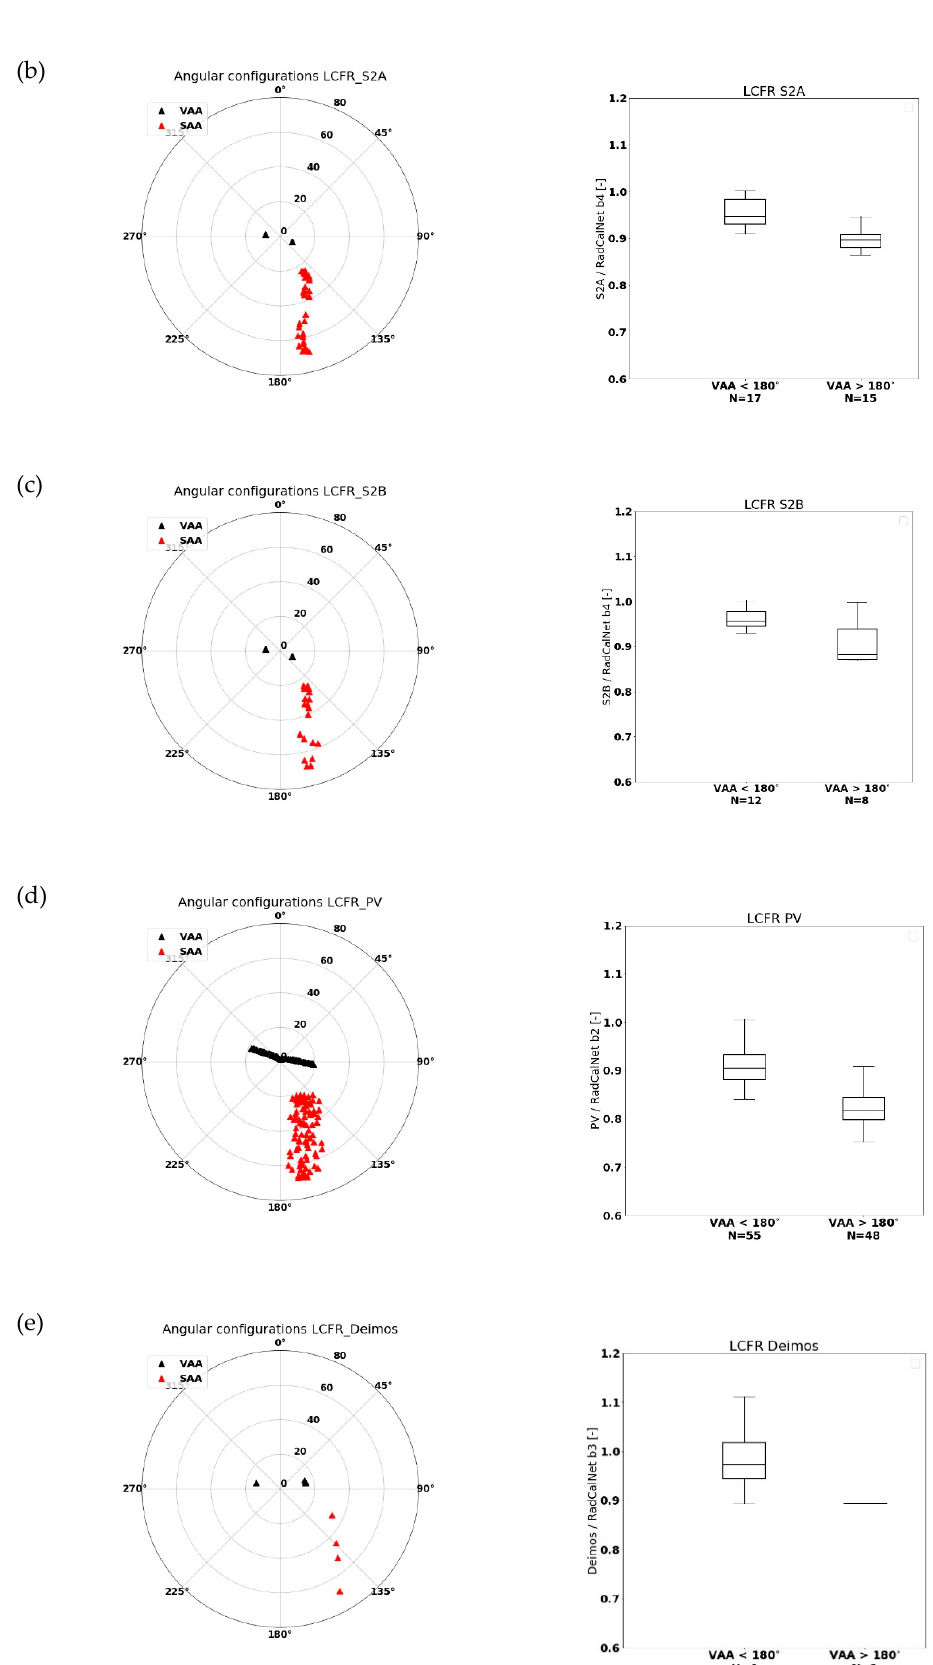
Figure 5. Similar to Figure 4, but for LCFR. Note that over this site subfigure ( e ), containing results for Deimos-1, is